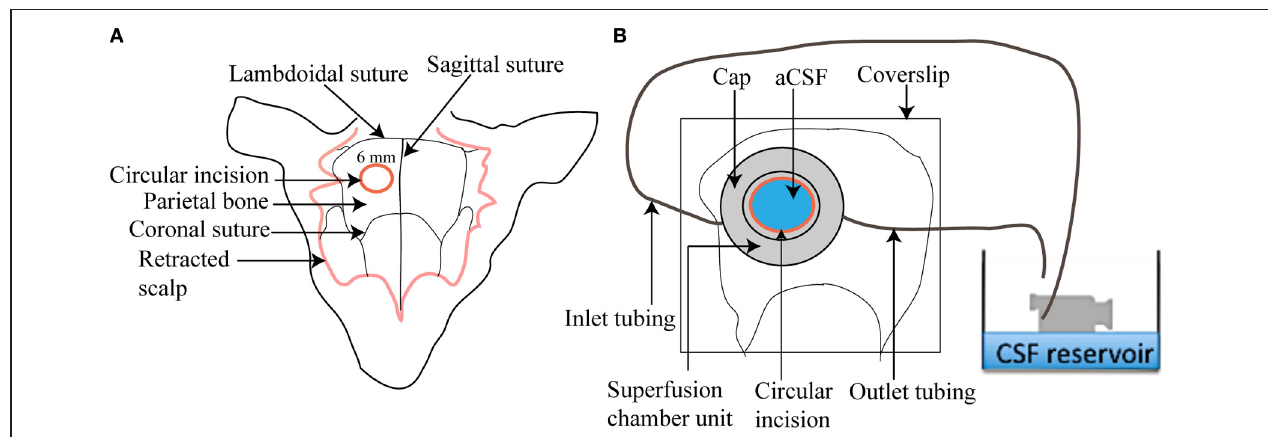
FIGURE 3 | Illustration of a superfusion chamber. (A) A circular incision of 6mm is made in the parietal bone after scalp retraction to form a cranial window (B) A magnified view of a superfusion chamber